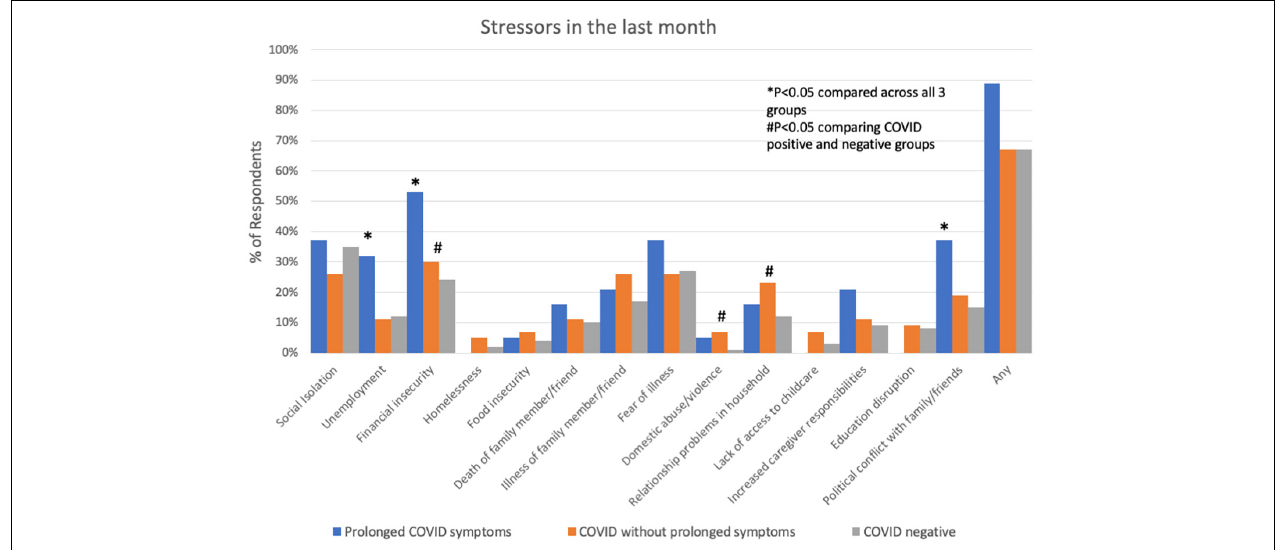
FIGURE 3 | Socio-economic stressors in the month prior to interview in subjects with prolonged COVID-19 symptoms, COVID-19 without prolonged symptoms and COVID-19 negative subjects. * P < 0.05 comparing across all three groups; # P < 0.05 comparing COVID positive to COVID negative.